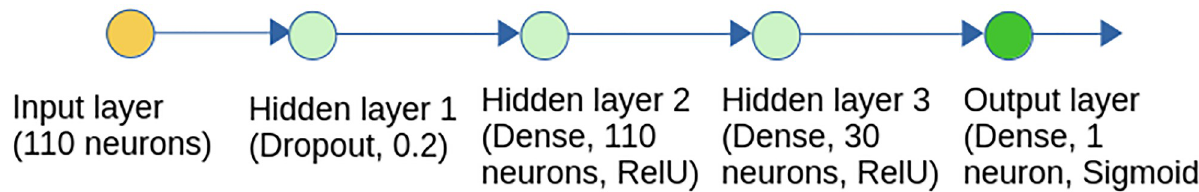
Fig 7. A simplified graph for the gender prediction neural network.